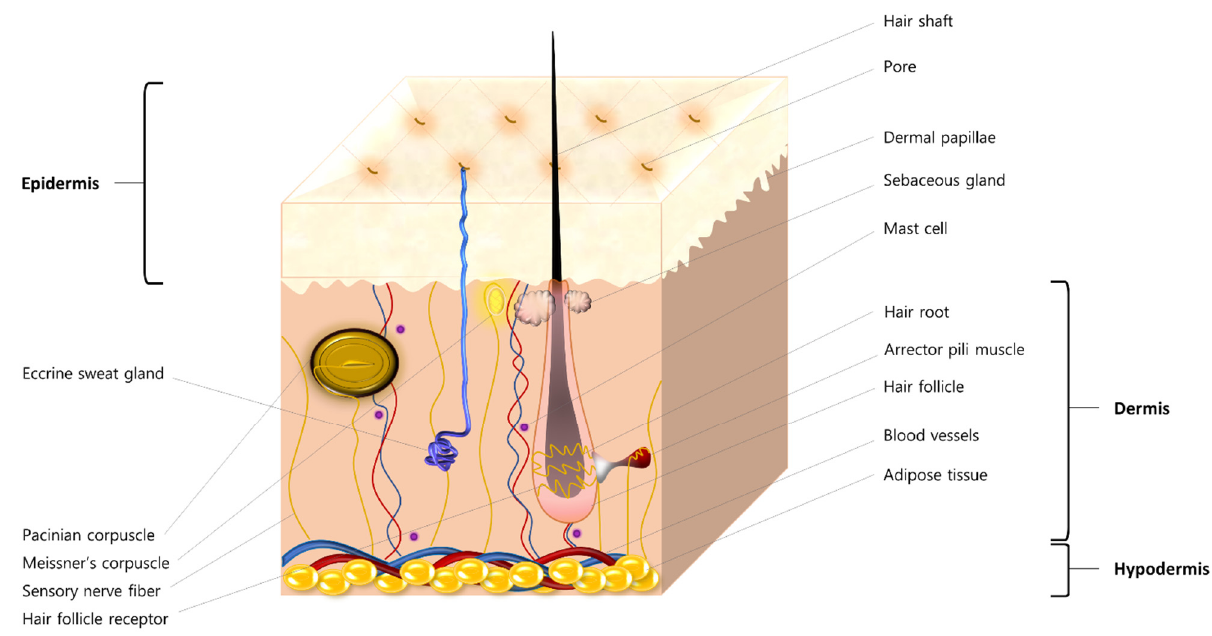
Figure 1. Anatomy of the integumentary system showing different structures within the epidermis, dermis, and hypodermis.